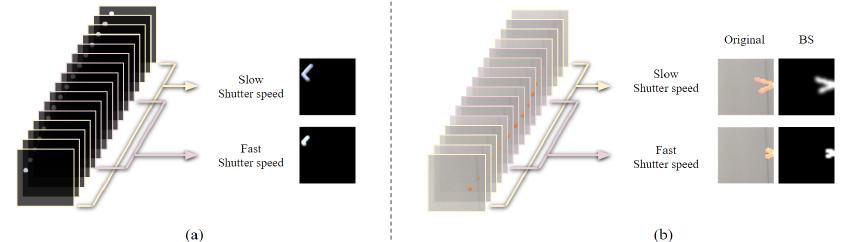
Figure 2. Synthesizing one blurry frame using consecutive clear frames, assuming different shutter speeds. ( a ) Result of synthesizing a blurry frame using synthetic frames. ( b ) Result of synthesizing